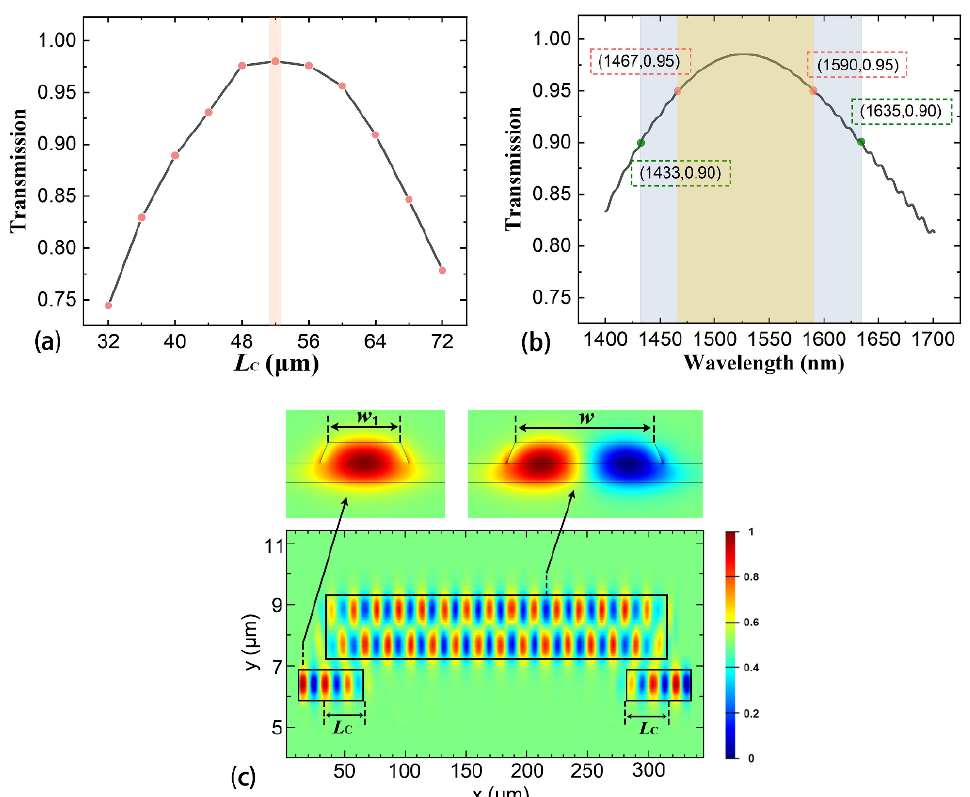
Figure 6. ( a ) Mode transmission from the input TE 0 to output TE 1 mode as a function of its coupling length L C . ( b ) Transmission wavelength spectrum for the mode converter. The optical bandwidths for transmission higher than 0.95 and 0.90 are marked with light yellow and light gray regions, respectively. ( c ) Electric field evolution through the whole conversion region from the input TE 0 mode to the converted TE 1 mode and then to the output TE 0 mode. The mode patterns of the input TE 0 mode and the converted TE 1 mode are shown in the insets. The coupling length L C = 52 μ m.